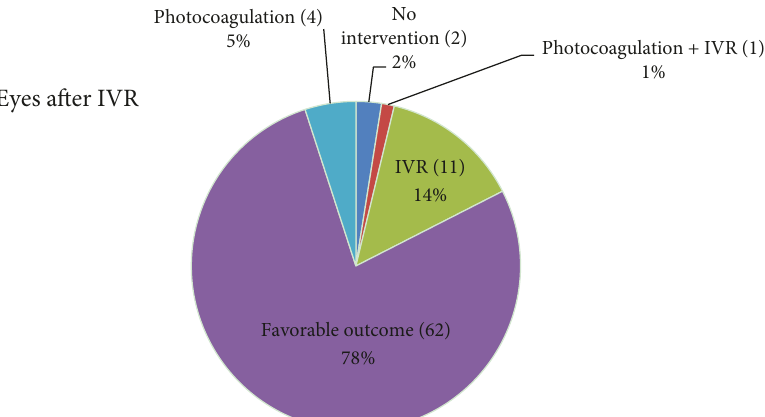
Figure 1: Results and secondary therapies of 80 eyes of infants with retinopathy of prematurity after initial ranibizumab treatment (IVR).